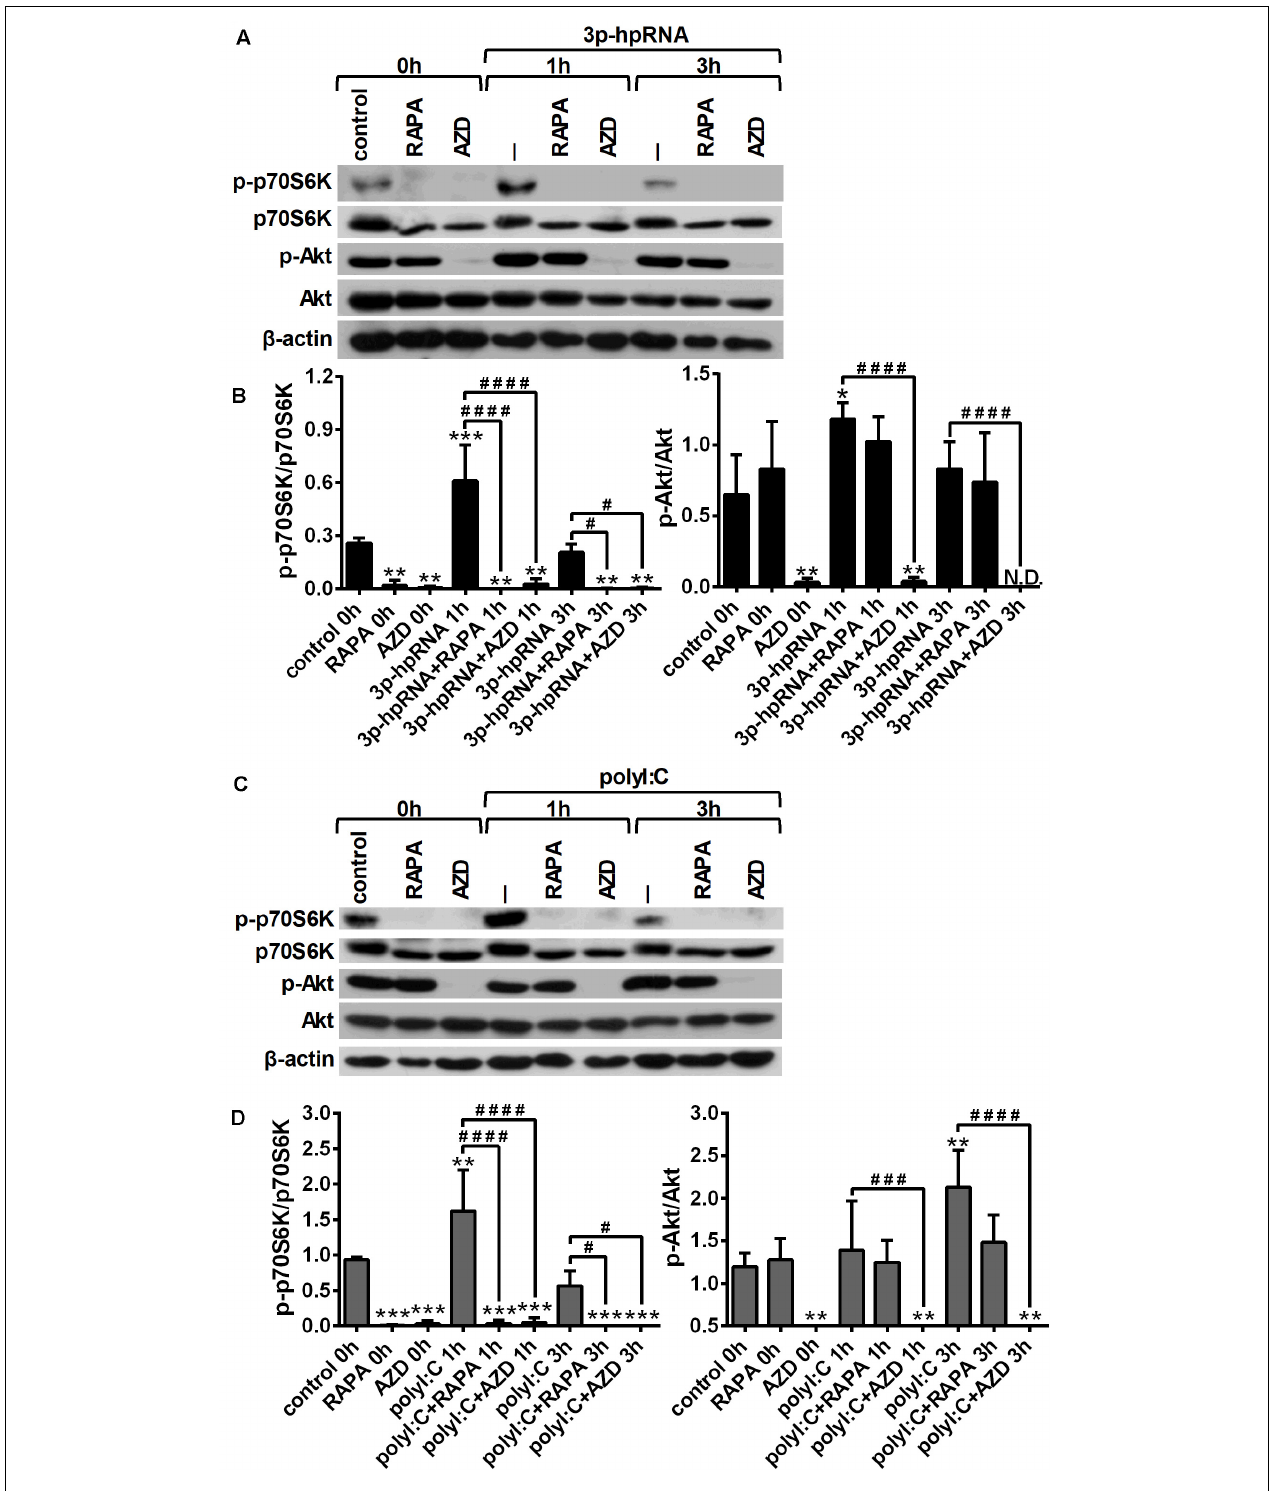
FIGURE 1 | RLR stimulation increases mTORC1 and mTORC2 activity in moDCs that is effectively inhibited by rapamycin and AZD8055 pre-treatment. Immature moDCs were pre-treated with vehicle control, 100 nM rapamycin (RAPA) or 100 nM AZD8055 (AZD) for 2 h then stimulated with 3p-hpRNA (0.5 µ g/ml) (A,B) or polyI:C (1 µ g/ml) (C,D) for different time periods. Kinetics of p70S6K and Akt phosphorylation were determined by western blotting. (A,C) Representative blots are shown. (B,D) Bar graphs represent the mean ± SD of at least 3 independent experiments. * p < 0.05, ** p < 0.01, *** p < 0.01 vs. control; # p < 0.05, ### p < 0.001, #### p < 0.0001. ND, not